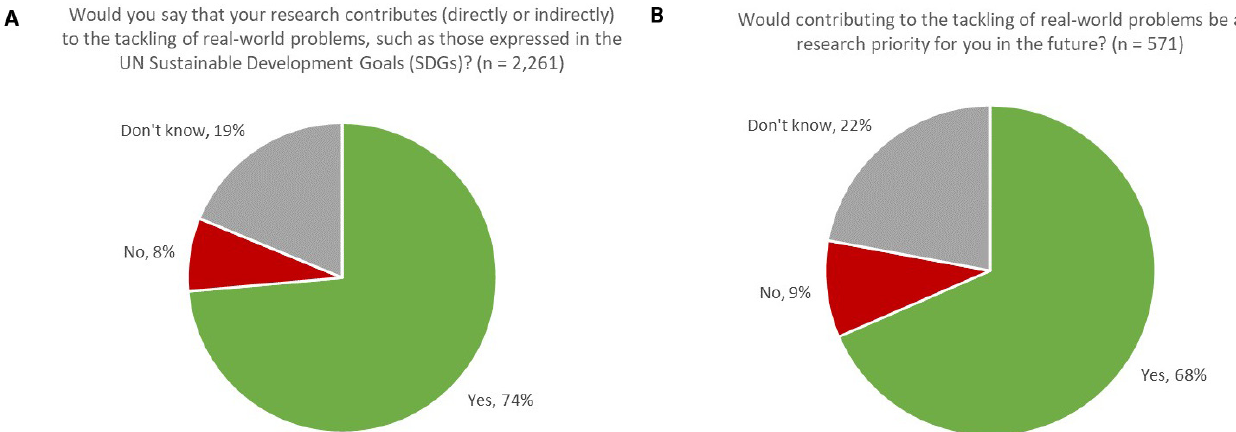
Figure 1. Proportion of respondents whose research contributes to tackling real-world problems, now ( A ) and in the future ( B